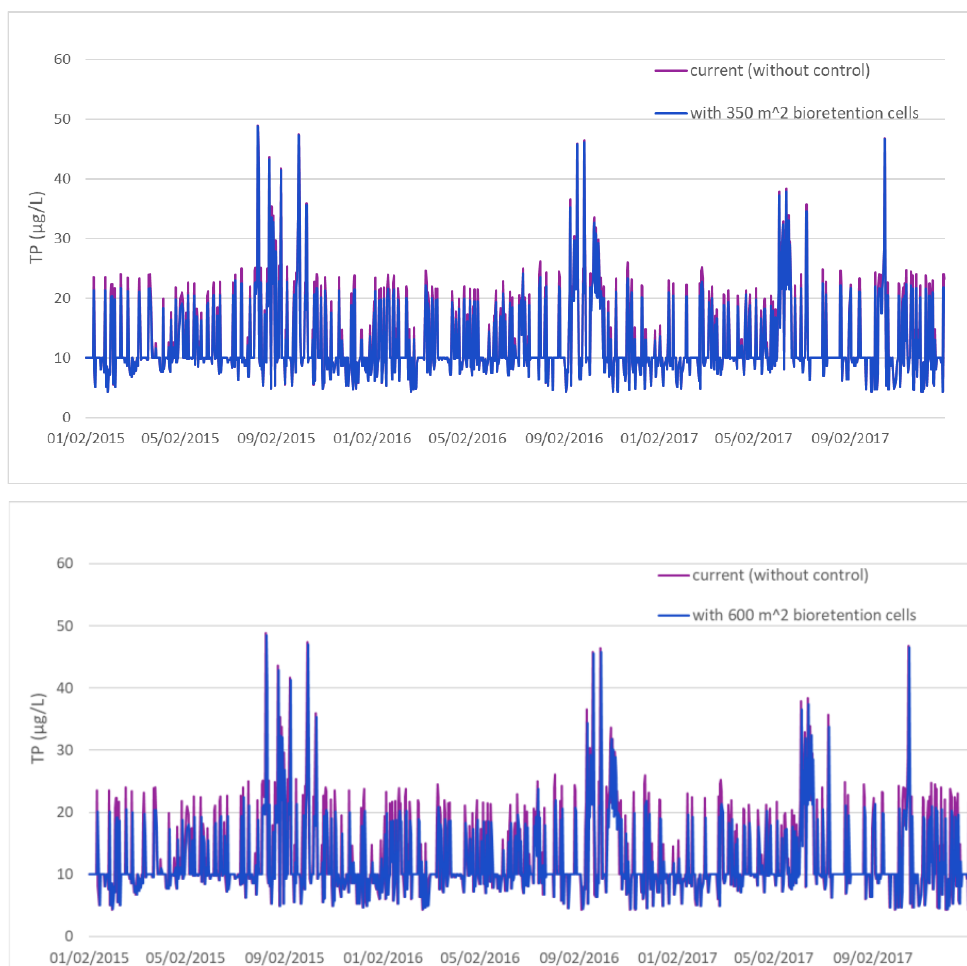
Figure 6. TP simulation results using different areas of bioretention cells. The upper panel shows